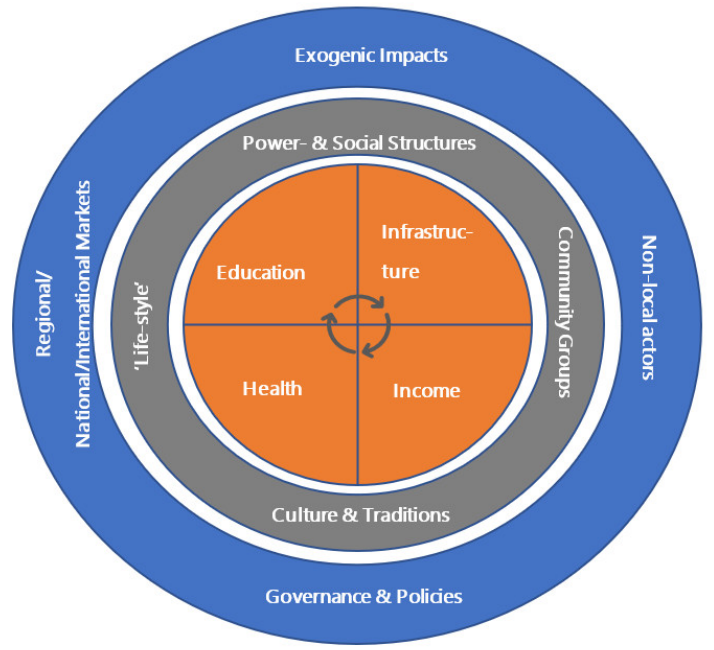
Figure 1. Community Ecosystem: suggested model of interrelated components and meta-level determinants (compiled by the authors).